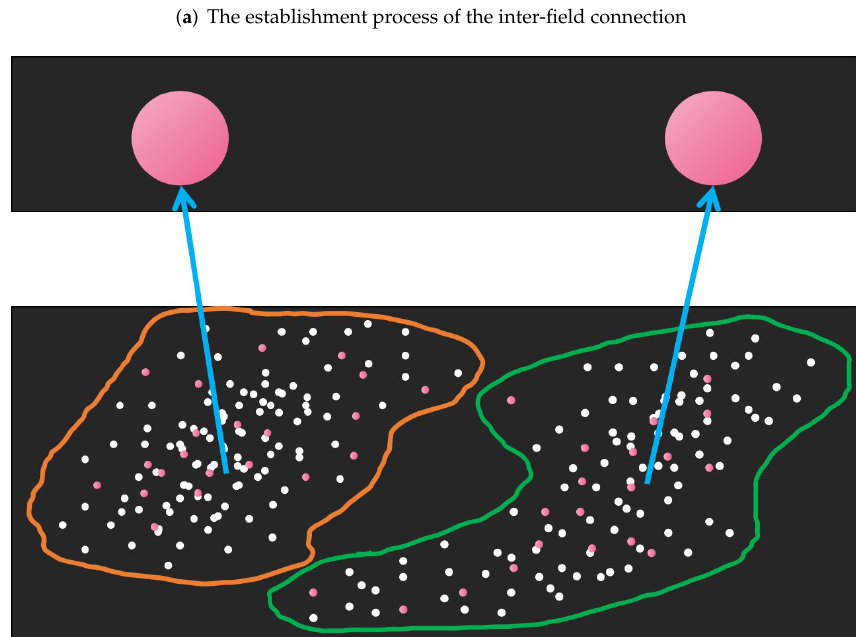
Figure 2. ( a ) shows the establishment process of the inter-field connection. ( b ) shows the neurons that have established inter-field connections. The white, pink and red ones represent implicit, explicit and activated neurons respectively. In ( a ), The thin blue arrows indicate an inter-field connection. The inter-field connections between the EPNs in the same subpopulation and ESN are indicated by a thick blue arrow in ( b